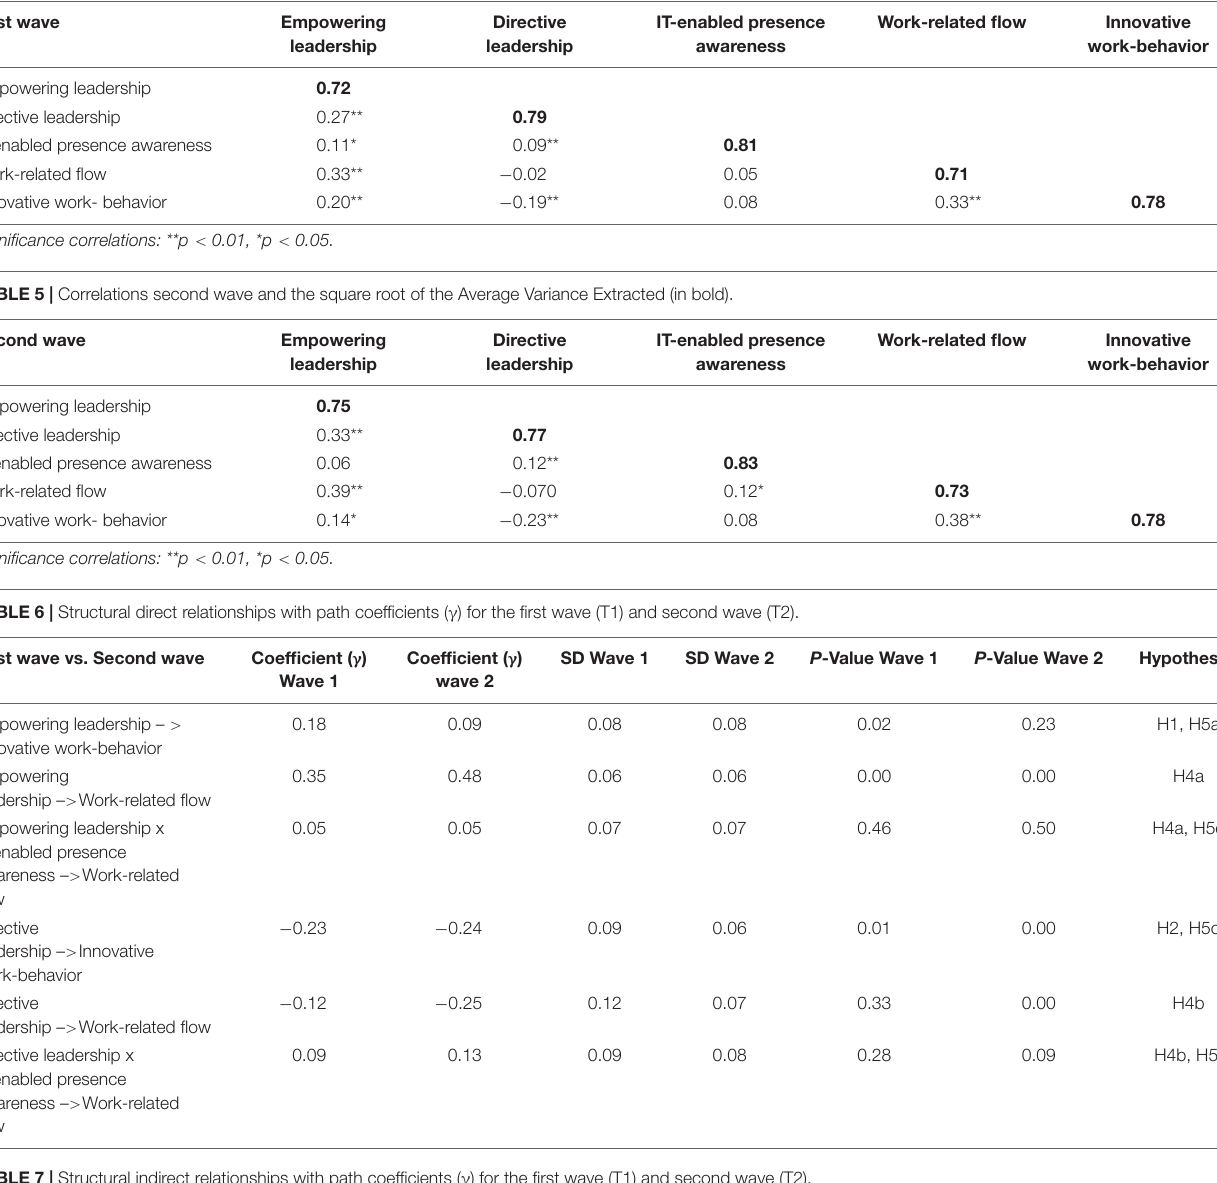
TABLE 7 | Structural indirect relationships with path coefficients ( γ ) for the first wave (T1) and second wave (T2). First wave vs. Second